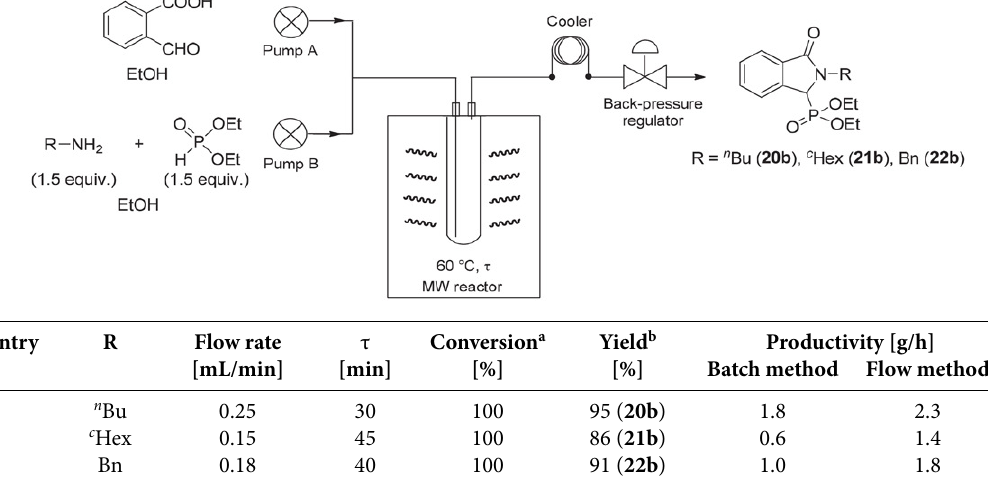
Table 1. Condensation of FBA , primary amines and diethyl phosphite ( DEP ) under continuous flow MW conditions